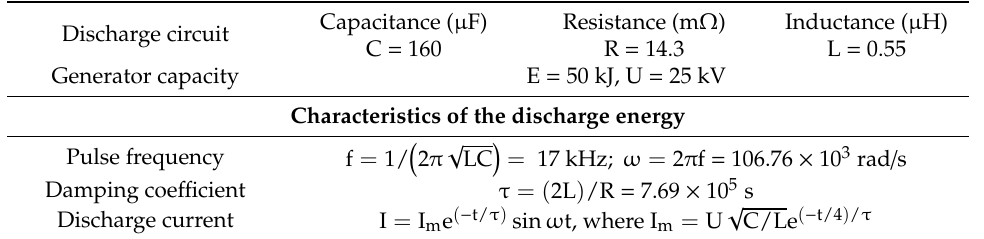
Table 1. Details of discharge circuit elements and energy characteristics.